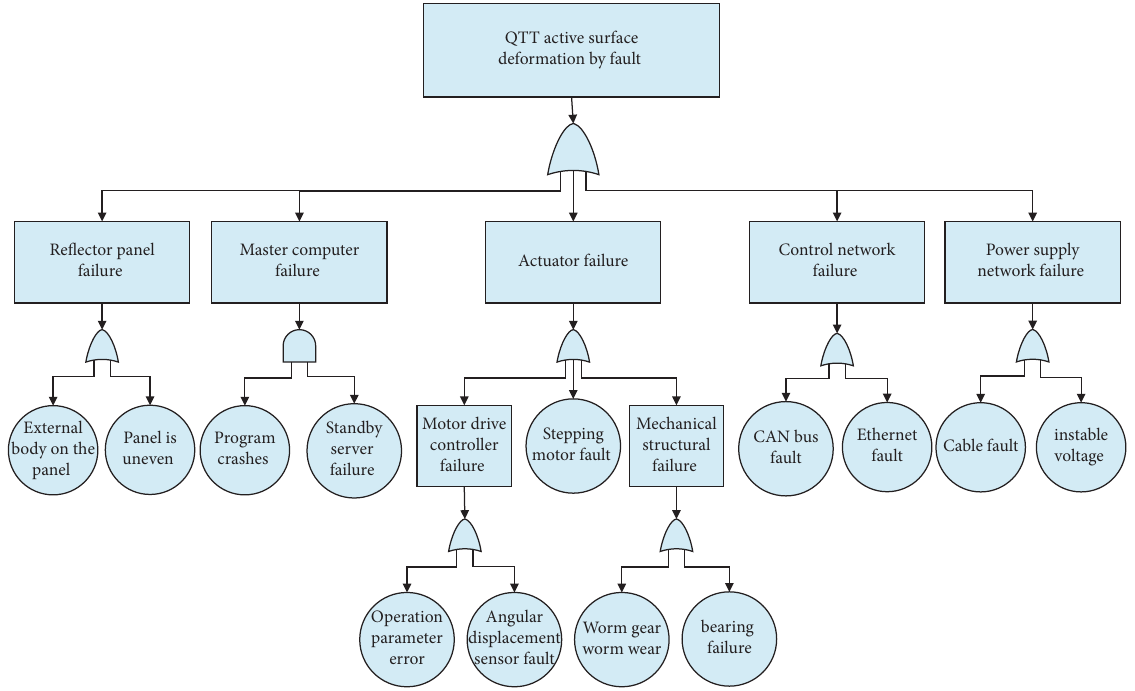
Figure 1: Active surface fault tree analysis [15].